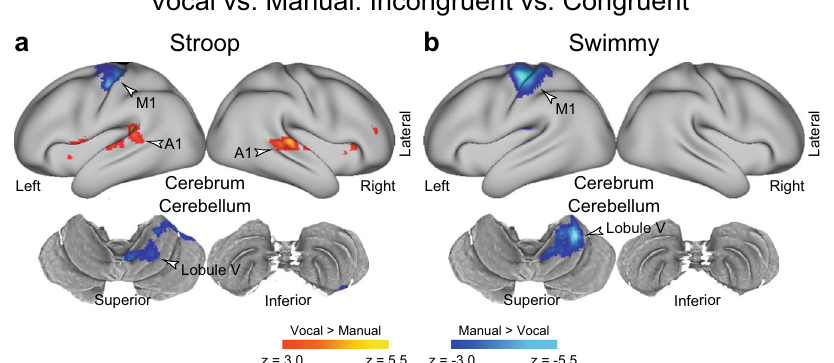
Fig. 5 | Response and stimulus modality effects. a , b Response type affects the involvement of sensory-motor regions, but not the fronto-cerebellar loop asso- ciated with interference resolution. Statistical maps showing a differential inter- ference effect (incongruent vs. congruent) between the vocal and manual conditions. Stroop task ( a ); Swimmy task ( b ). Hot and cool colors indicate greater interference effect in the vocal and manual conditions, respectively. c The Stroop